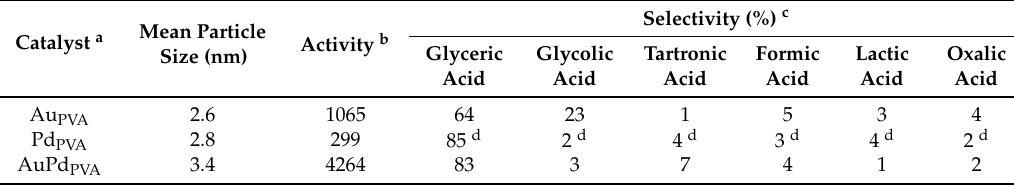
Table 1. Catalytic results in liquid phase oxidation of glycerol.